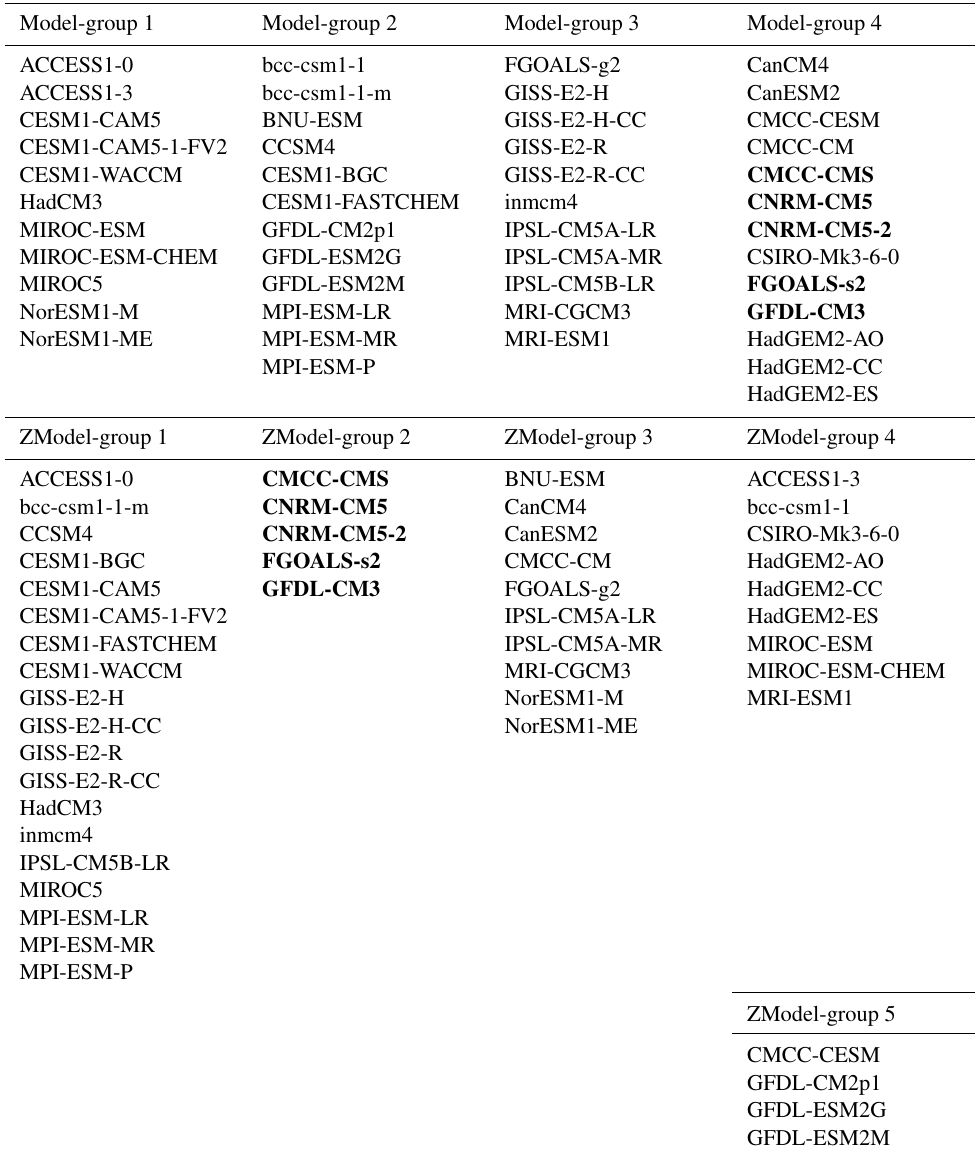
Table A1. Composition of the different model groups identified in the main text. In bold, we show the CMIP5 models which belong to Model-group 4 and ZModel-group 2. We note that all the models belonging to Zmodel-group 2 also belong to Model-group